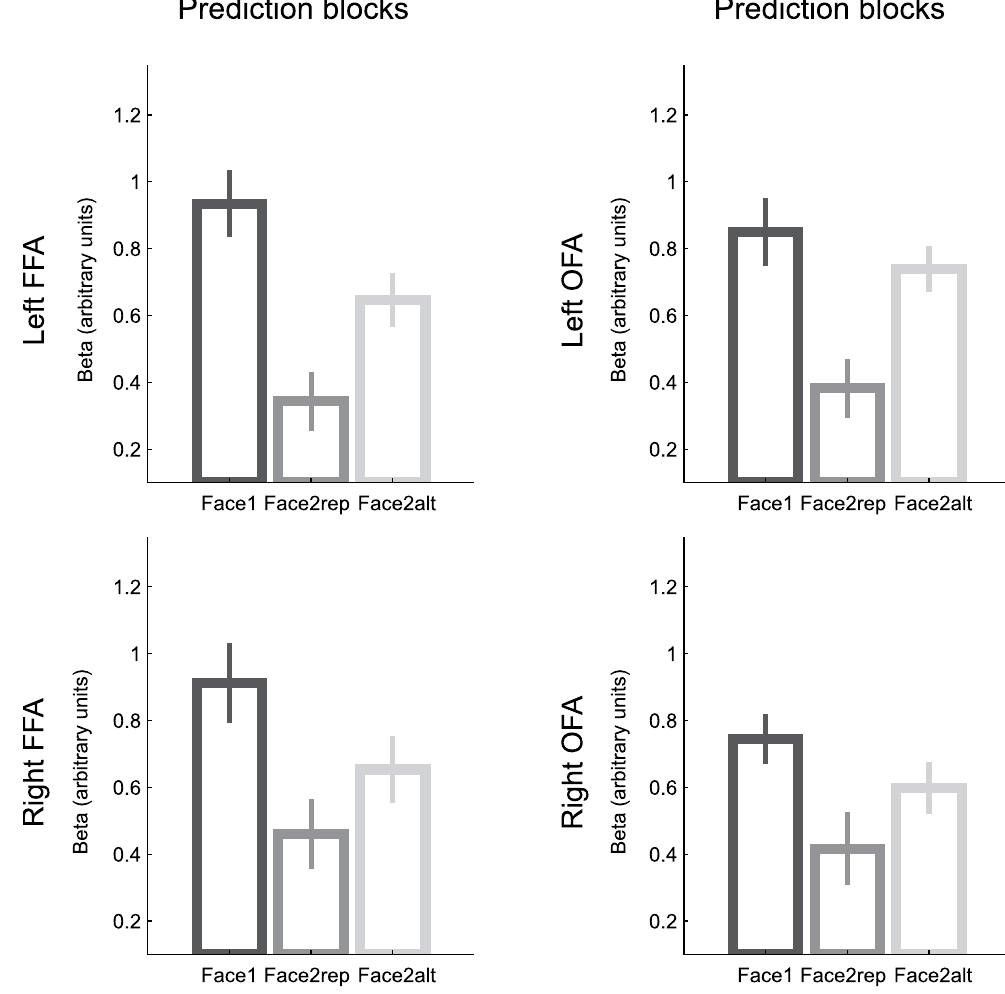
Figure 3. Parameter estimates (mean ± s.e.m. across 28 participants) for Face1, Face2alt and Face2rep, in the left and right FFA and OFA, during Prediction